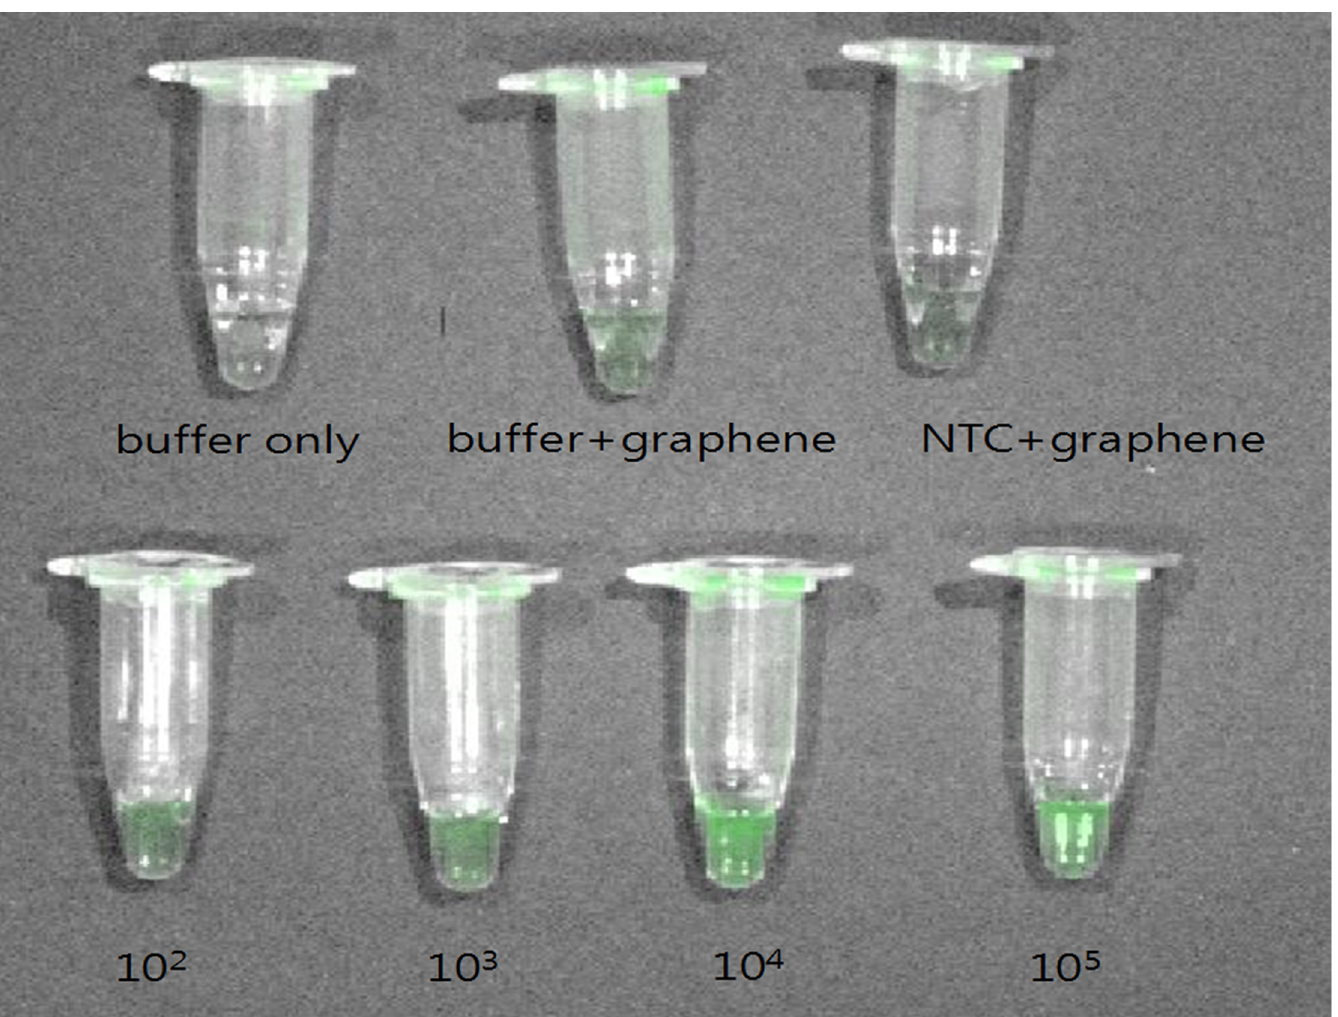
Fig 2. Fluorescence signaling after PCR-GO is proportional to the amplicon concentration. Fluorescence in tubes containing 0 (NTC) to 10 5 copies/ reaction of a plasmid encoding the IS 6110 sequence is shown. Twenty microliters of a 1 mg/mL stock of GO was added at a final concentration 0.2 mg/mL. The fluorescence images were obtained using the IVIS Lumina Series Ⅲ imaging system. NTC, no-template